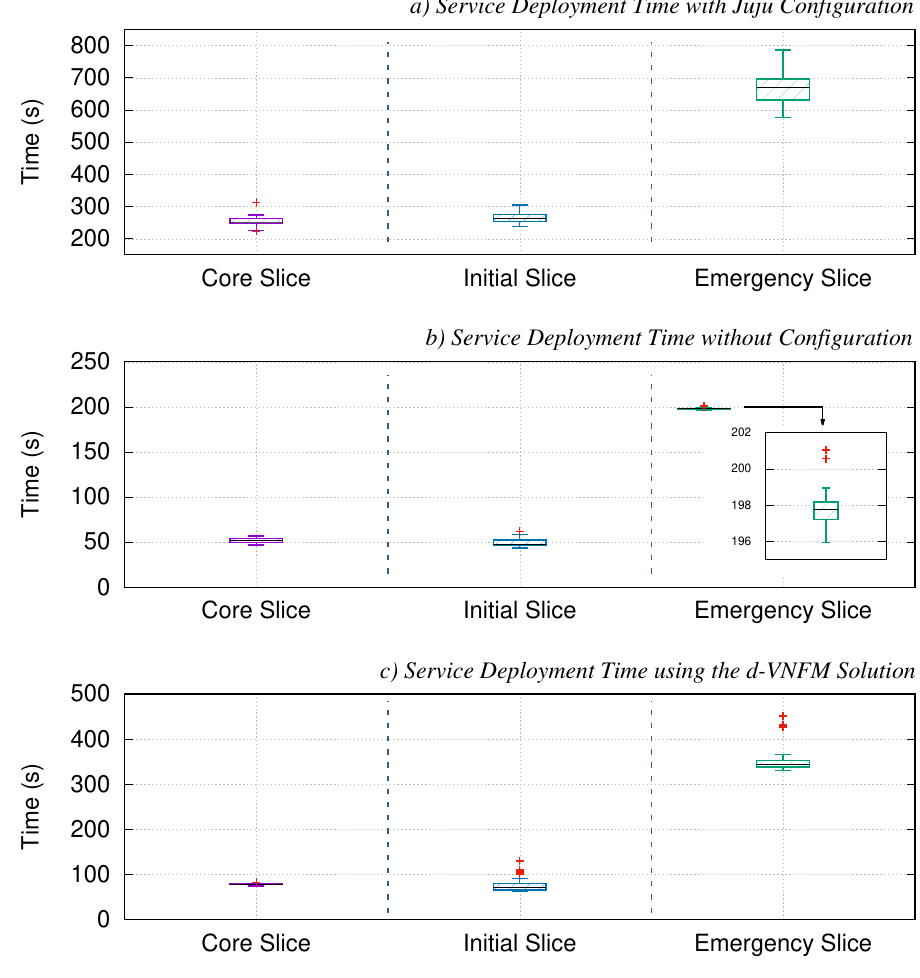
Figure 6. Service deployment time measurements of each